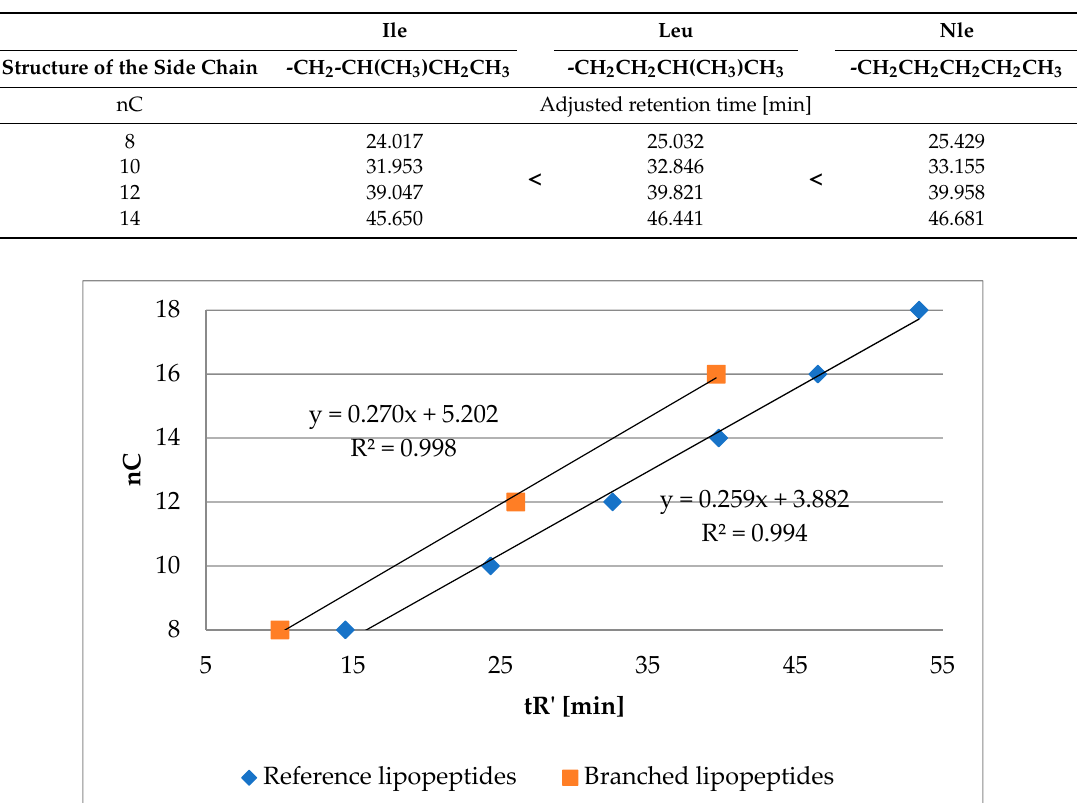
Figure 4. Number of carbon atoms in the fatty acid chain (nC) of branched lipopeptides ( 103 – 105 ) and reference lipopeptides ( 1 – 6 ) versus adjusted retention time.